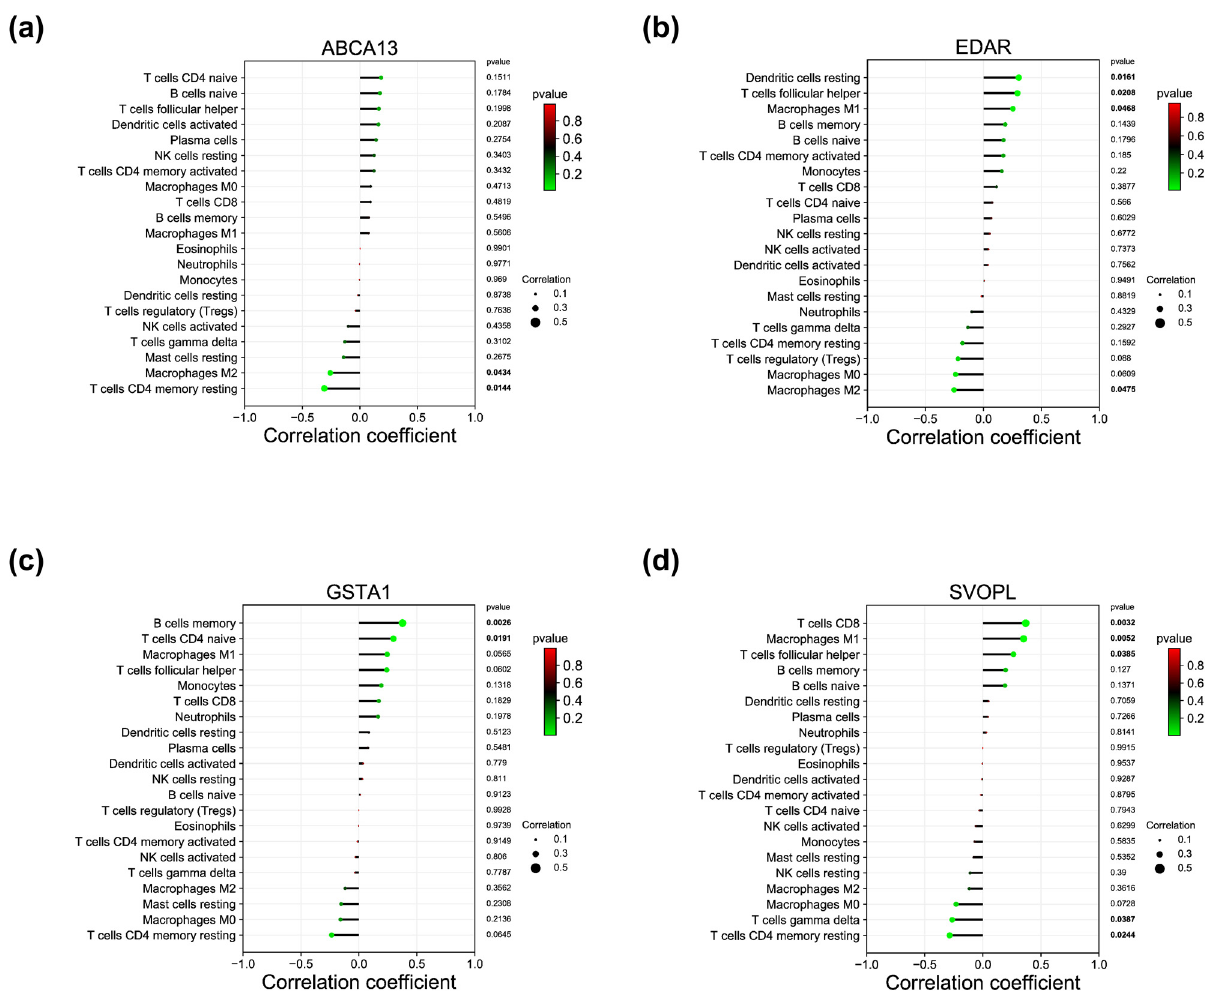
Figure 7: Correlation analysis between in fi ltrating immune cells and diagnostic biomarkers. The bar diagram showed the correlation between ( a ) ABCA13, ( b ) EDAR, ( c ) GSTA1, ( d ) SVOPL, and in fi ltrating immune